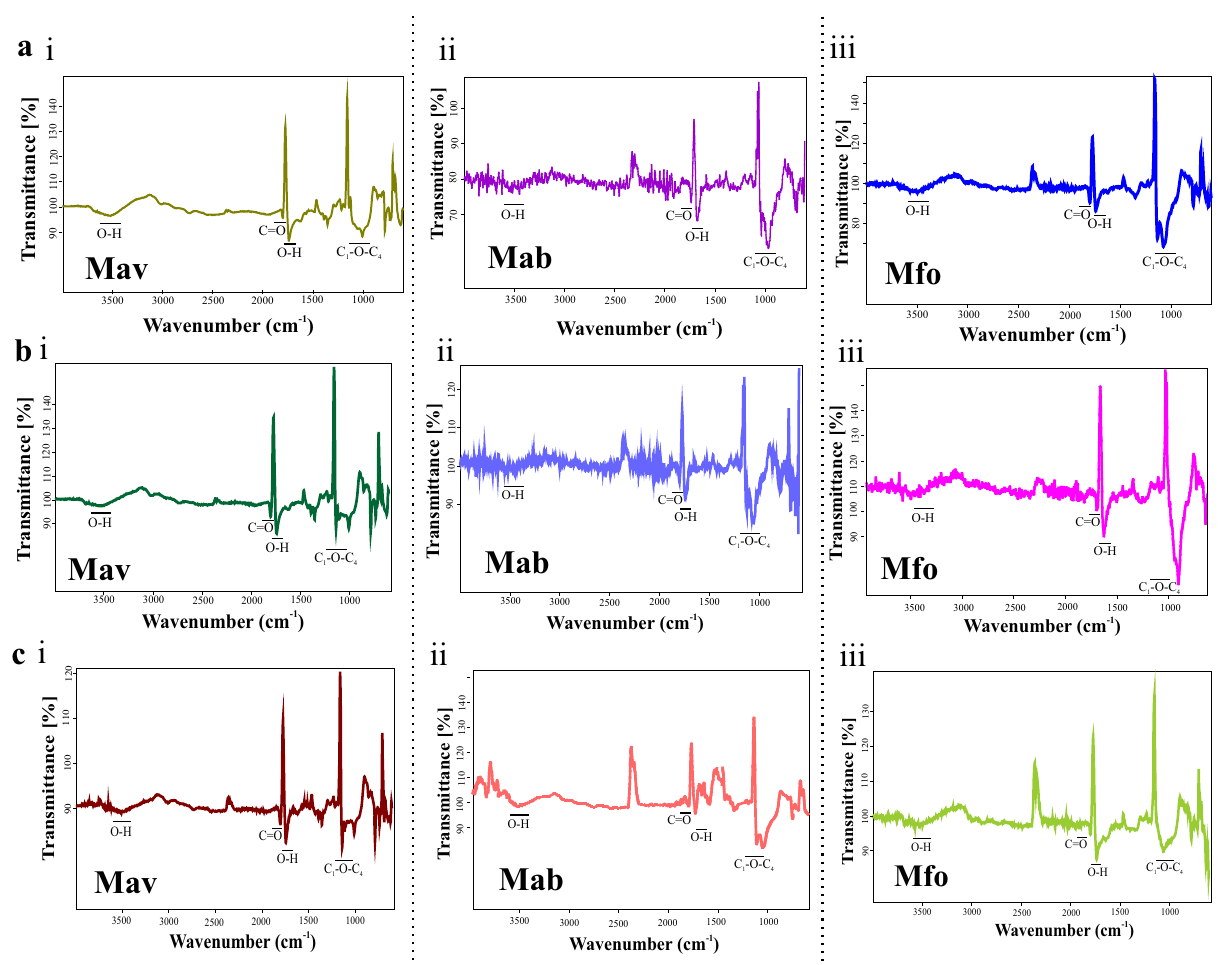
Fig. 3 Characterization of bio fi lm matrix polysaccharides. a – c Cellulose was puri fi ed from submerged bio fi lms ( a ), pellicle bio fi lms ( b ) and macrocolony bio fi lms ( c ) of Mav ( i ), Mab ( ii ) and Mfo ( iii ) and then subjected to FTIR analysis. All the experiments are representatives of at least three biological experiments performed with three technical replicates